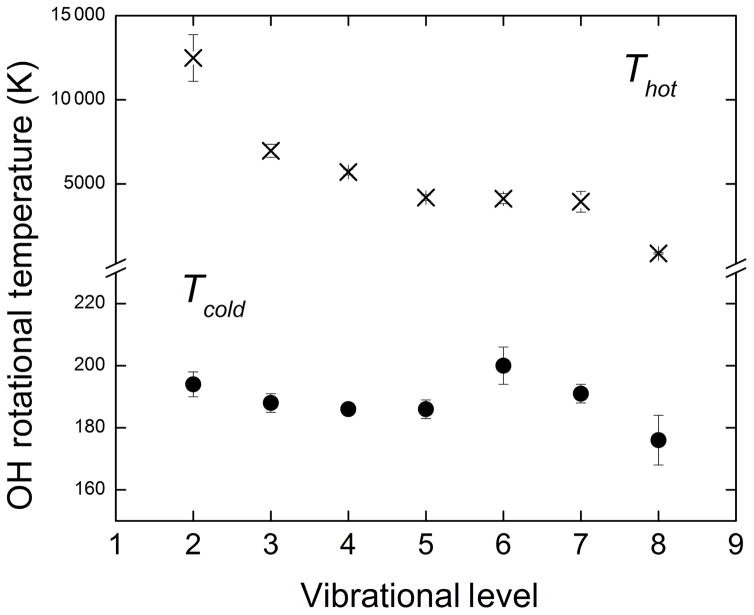
Results for OH(υ) Tcold (solid circles) and Thot (slanted crosses) rotational temperatures obtained from simultaneous two-temperature fits of the data set reported by Oliva et al. (2015).